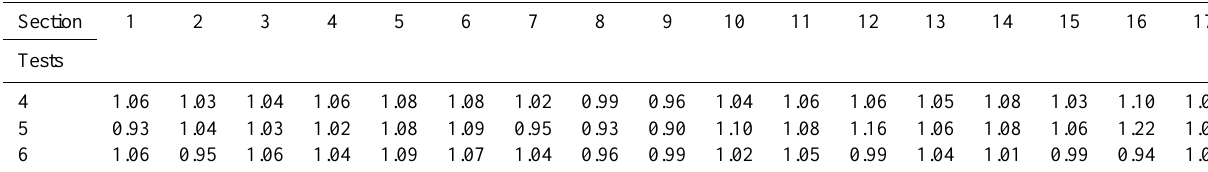
Table 2. Ratio of entrained sediment particles to the deposited particles (RNED) for triangular ripples.